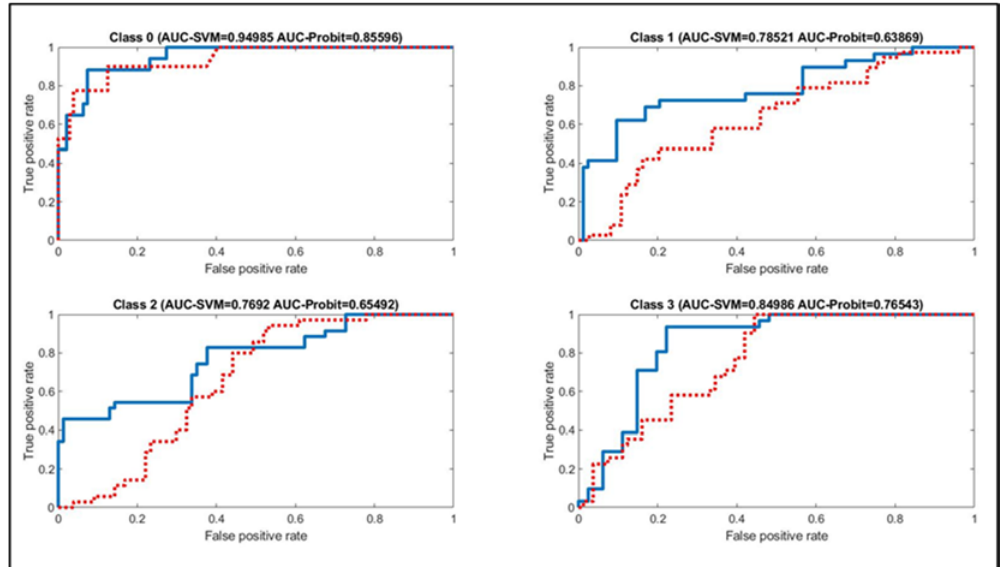
Figure 2. Area Under the Receiver Operating Curve. The line of the SVM model (blue continuous) outperforms the respective line of the Probit model (red dashed). The area under the curve (AUC) for each model is reported for each class and model, respectively. Table 10. Bank Rating forecasting accuracy by the SVM model